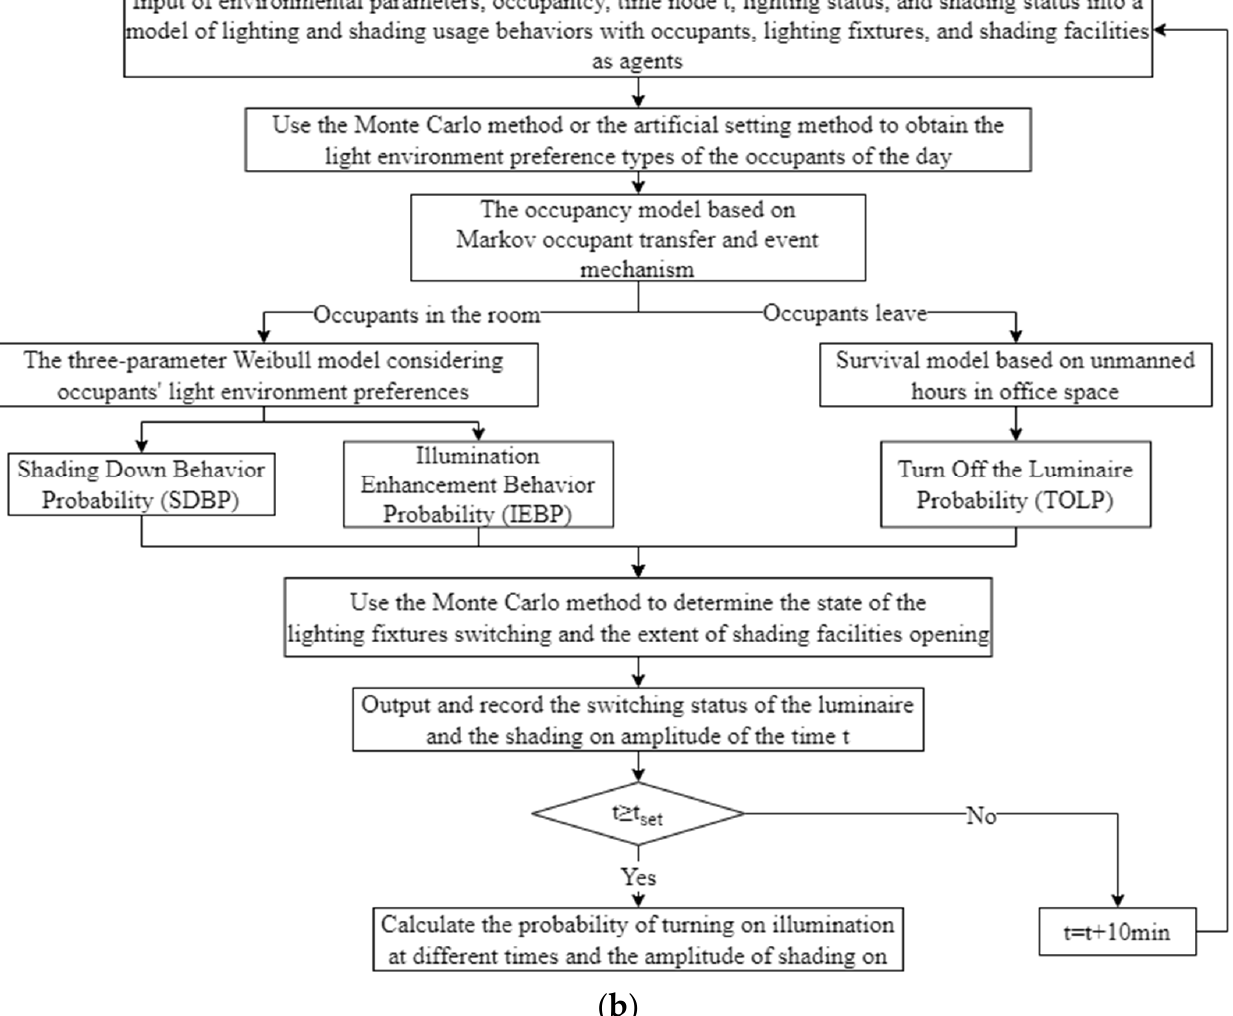
Figure 1. ( a ) The modeling process and internal operation rules of agent-based air conditioner usage behaviors (SET*, the standard effective temperature is an equivalent temperature index that assumes that people in the actual environment have the same mean skin temperature and skin wetness as those in an imaginary standard environment), ( b ) the modeling process and internal operation rules of agent-based lighting fixtures and shading facilities usage behaviors.